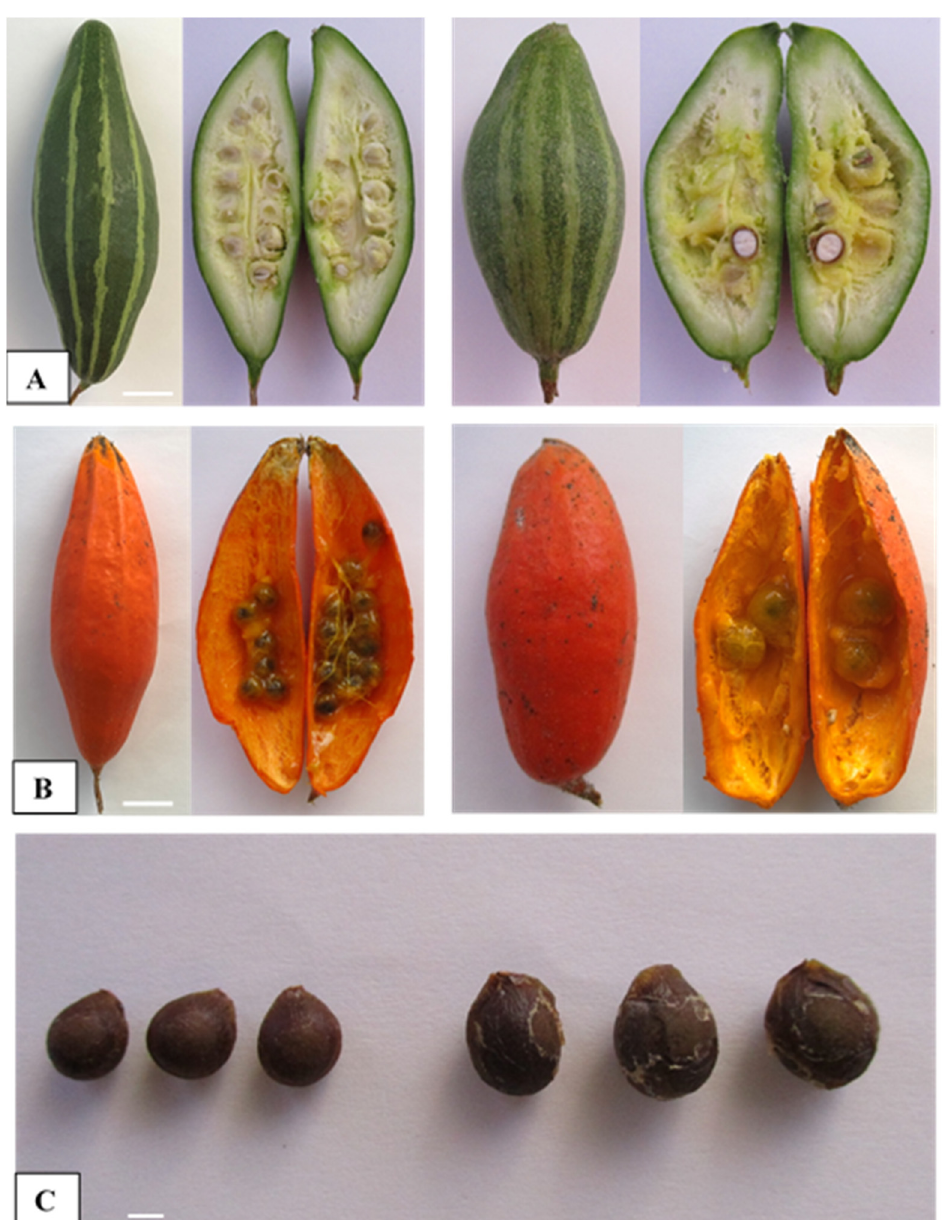
Figure 6. Fruit and seed traits after crossing between the diploid and colchicine-induced tetraploid of pointed gourd. A cross-section of the fruit at the green stage ( A ), the ripening stage ( B ), and mature seeds ( C ) produced from the 2x × 2x cross (left) vs. the 4x × 2x cross (right), which produce fruits with few but large seeds. Bar indicates 1 cm for fruit and 2 mm for seed diameter.